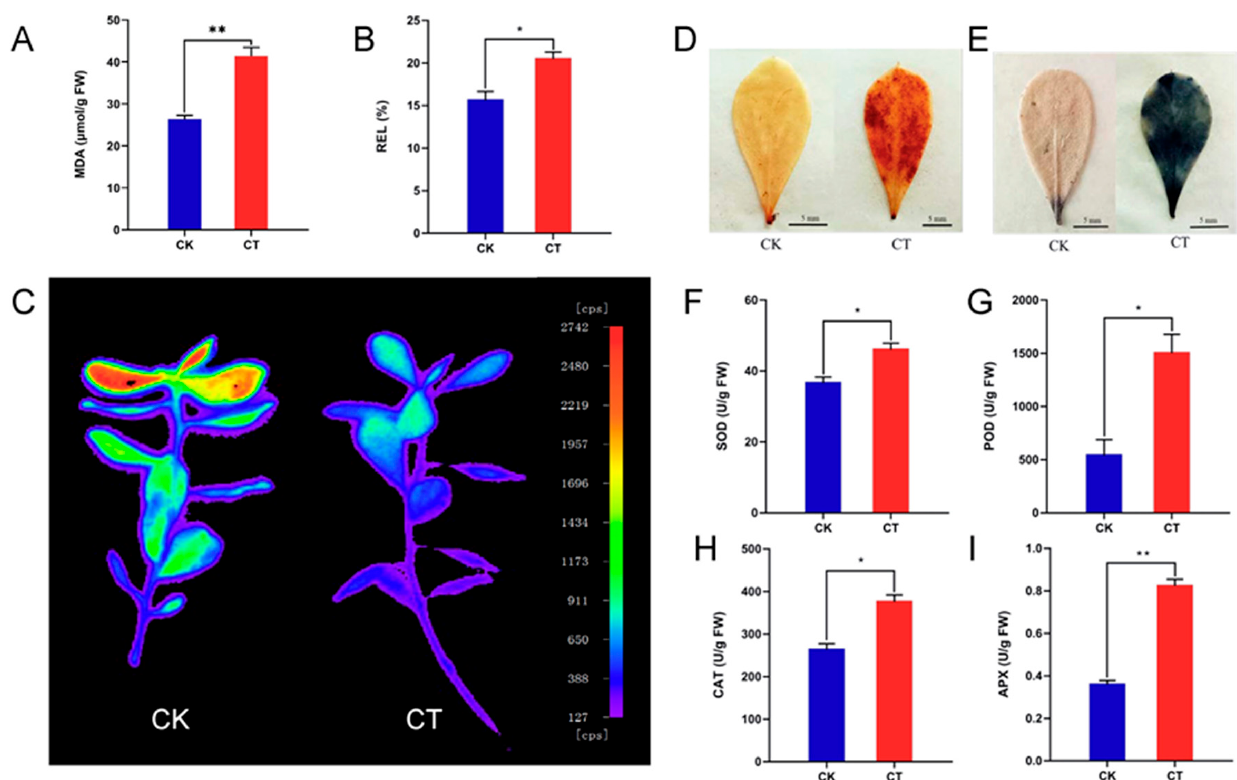
Figure 1. The physiological and biochemical indexes of A. nanus seedlings under cold stress. ( A ) The content of MDA. ( B ) REL values. ( C ) Delayed fluorescence images of the CK and CT. ( D ) DAB staining shows the site of H 2 O 2 accumulation in leaves under cold stress. The darker the color, the more H 2 O 2 is accumulated. ( E ) NBT staining shows the site of O 2 − accumulation in A. nanus leaves under cold stress. The darker the blue color, the more O 2 − is accumulated. ( F ) The enzyme activities of SOD. ( G ) The enzyme activities of POD. ( H ) The enzyme activities of CAT. ( I ) The enzyme activities of APX. Each experiment was performed in three independent biological replicates. Values are expressed as means ± SD ( n = 3), and the statistically significant differences were evaluated using Student’s t -test, * p < 0.05, ** p < 0.01.